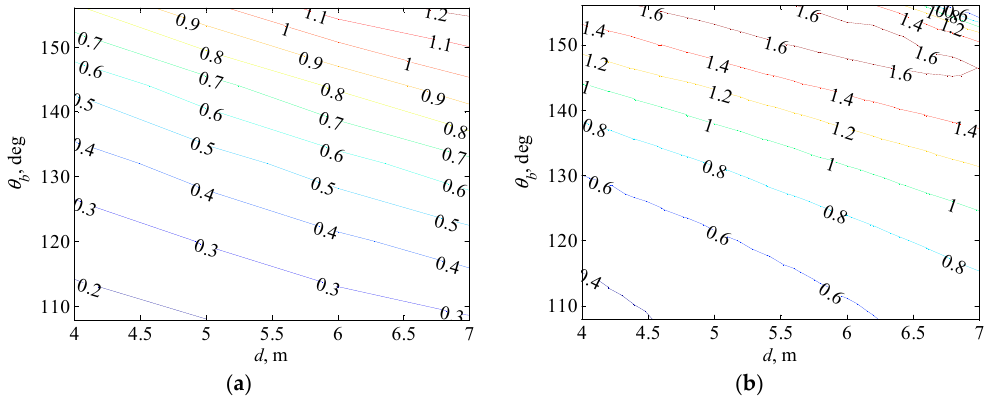
Figure 11. Pressure moment and pressure moment coefficient as a function of depth of rotation axis and beak angle: ( a ) pressure moment M P /10 8 N·m; and ( b ) pressure moment coefficient K P /10 8 N·m·rad − 1 .